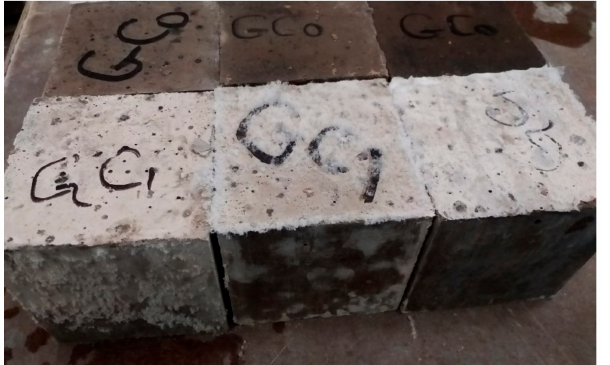
Figure 5. Appearance of efflorescence on the surface of geopolymer concrete specimens with higher alkaline